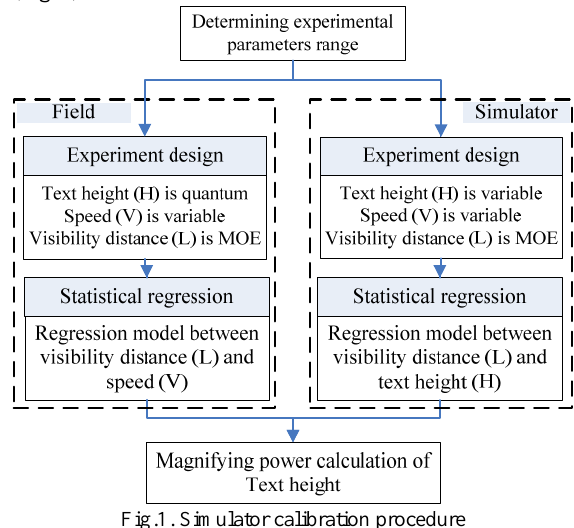
Fig.1. Simulator calibration